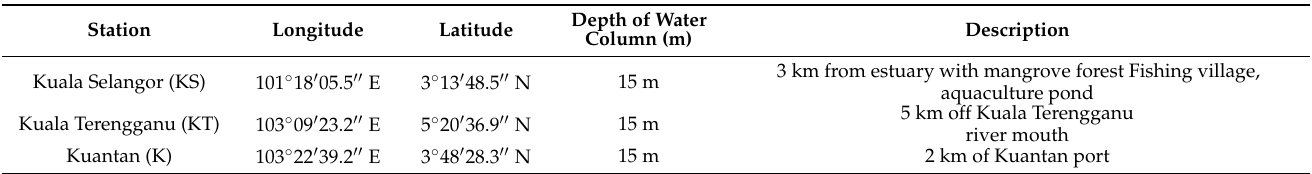
Figure 1. Location of sampling stations in this study. Table 1. Description of sampling stations.